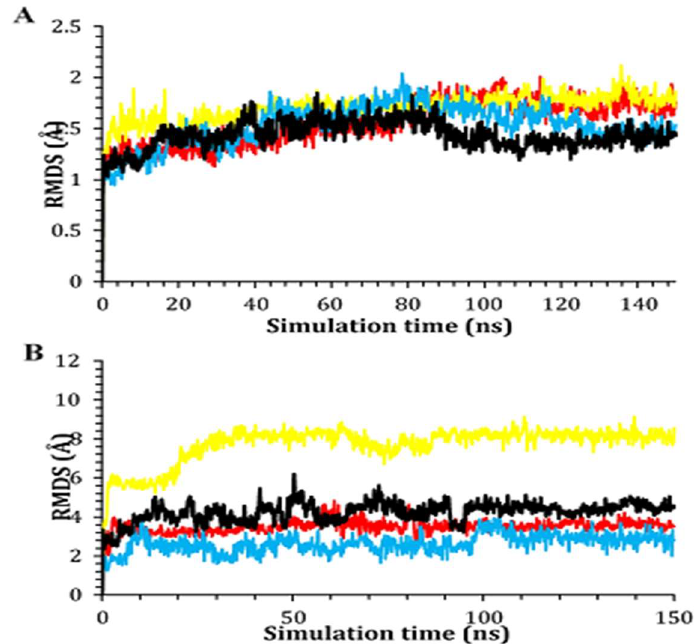
Figure 6. The RMSD of ( A ) the best two protein complexes and ( B ) the best two ligands within the binding pocket of acetylcholinesterase (1OCE) compared to both donepezil and the co-crystallized MF2 700 inhibitor as a function of simulation time (150 ns). Normethyl budmunchiamine K, bud- munchiamine L5, donepezil and the co-crystallized MF2 700 are colored red, yellow, blue and black, respectively.